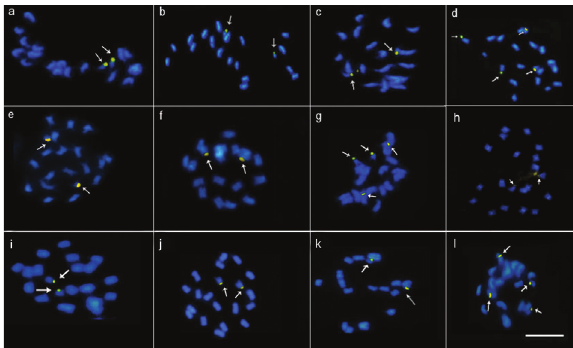
Figure2 -5S(red)and35S(green)probesmappedin Stylosanthes species by fluorescent in situ hybridization. (a) S. hippocampoides , (b) S. gracilis , (c) S. grandifolia , (d) S. macrocephala , (e) S. acuminata , (f) S. ruellioides , (g) S. guianensis LC2538, two extra points are distended satellites, (h) S. guianensis cv. Mineirão, (i) S. guianensis 4171, two extra points are dis- tended satellites, (j) S. guianensis 1480 Bar = 10 (cid:2)